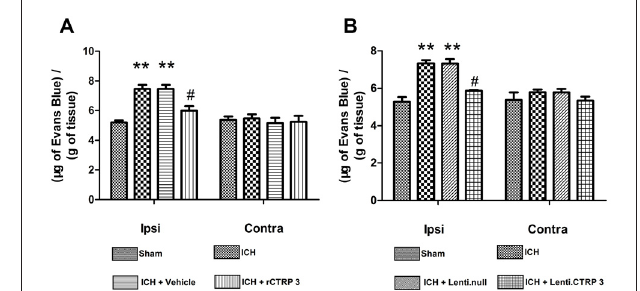
FIGURE 3 | Effects of CTRP3 treatment on ICH-induced blood-brain barrier (BBB) damage 7 days after ICH. (A) Quantification of Evans blue dye extravasation (blue staining) in the ipsilateral (Ipsi) and contralateral (Contra) hemispheres 7 days after ICH in rats treated with rCTRP3. (B) Quantification of Evans blue dye extravasation (blue staining) in ipsilateral (Ipsi) and contralateral (Contra) hemispheres 7 days after ICH in rats treated with Lenti-CTRP3. Values are mean ± SEM. n = 6 per group. ∗∗ p < 0.01 vs. sham; # p < 0.05 vs. vehicle or Lenti.null. CTRP3, C1q/tumor necrosis factor-related protein-3; rCTRP3, recombinant CTRP3; Lenti-CTRP3, Lentivirus overexpression of CTRP3; ICH, intracerebral